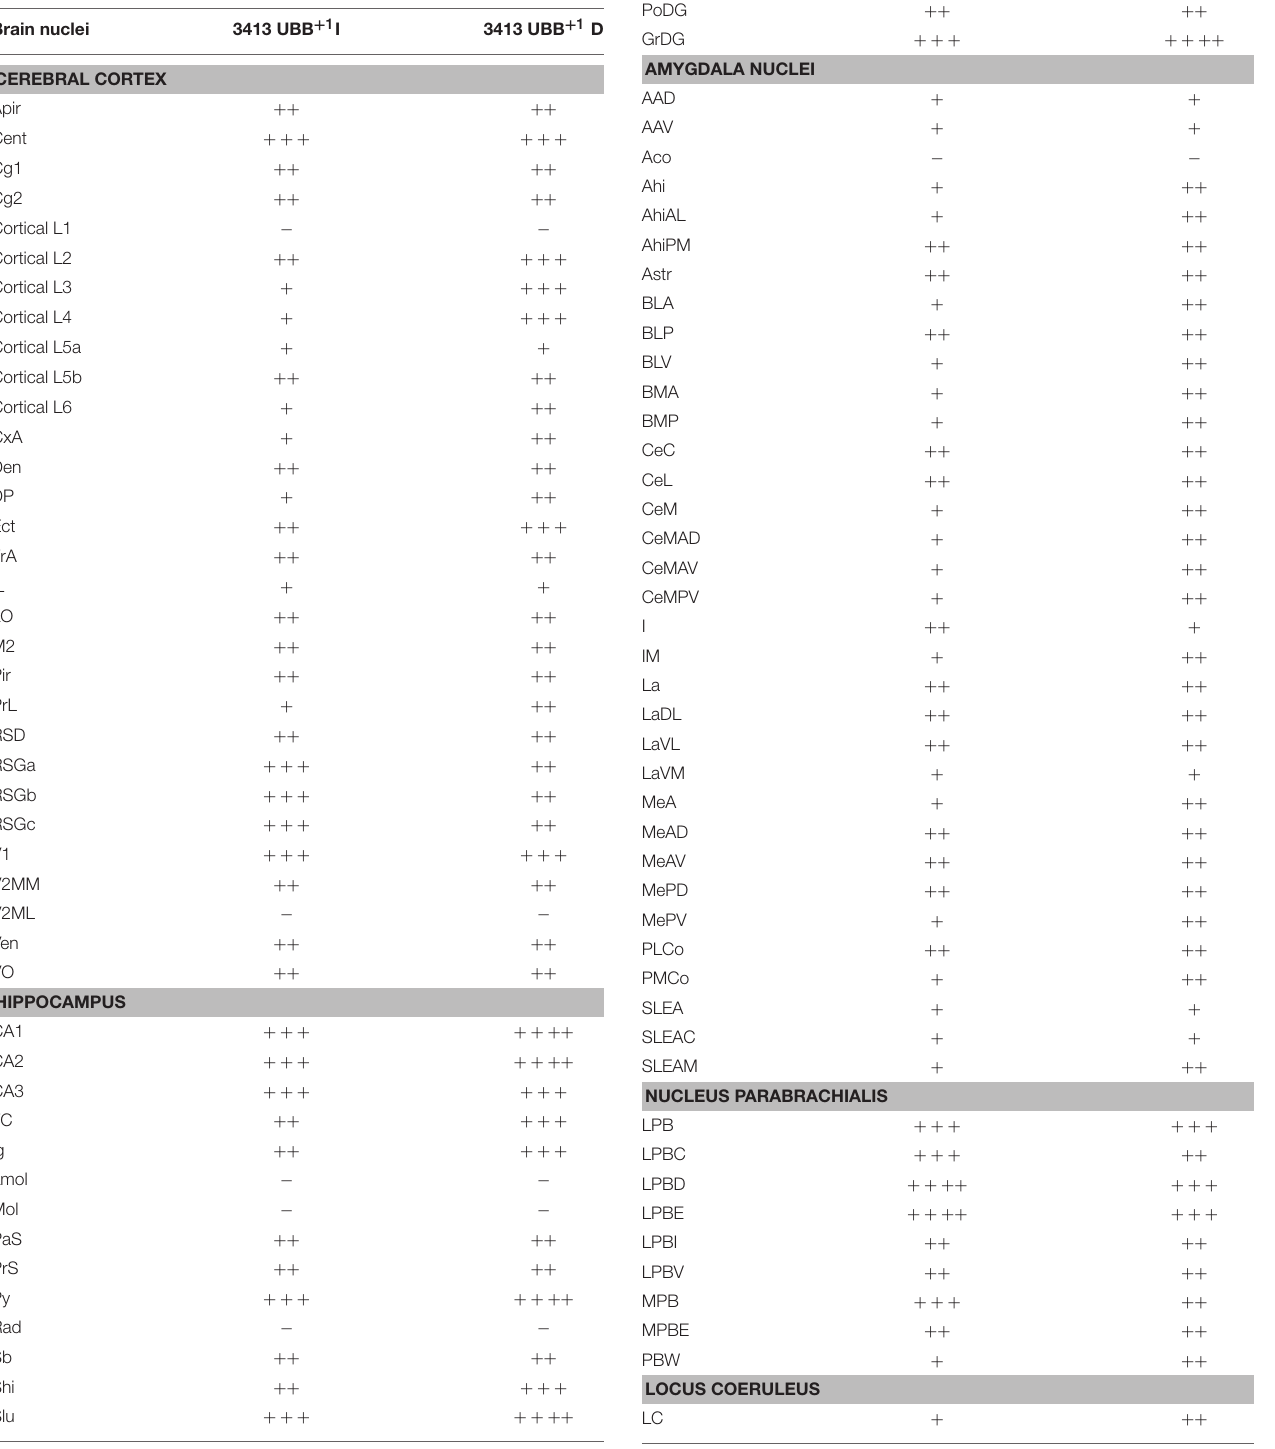
TABLE 2 | UBB + 1 immunoreactivity in the cerebral cortex, hippocampus, dentate gyrus, striatum, amygdala, nucleus parabrachialis, locus coeruleus, nucleus of the tractus solitarius, olfactory area, basal ganglia, nucleus basalis of Meynert, auditory area and in the raphe nuclei of 3413 tg